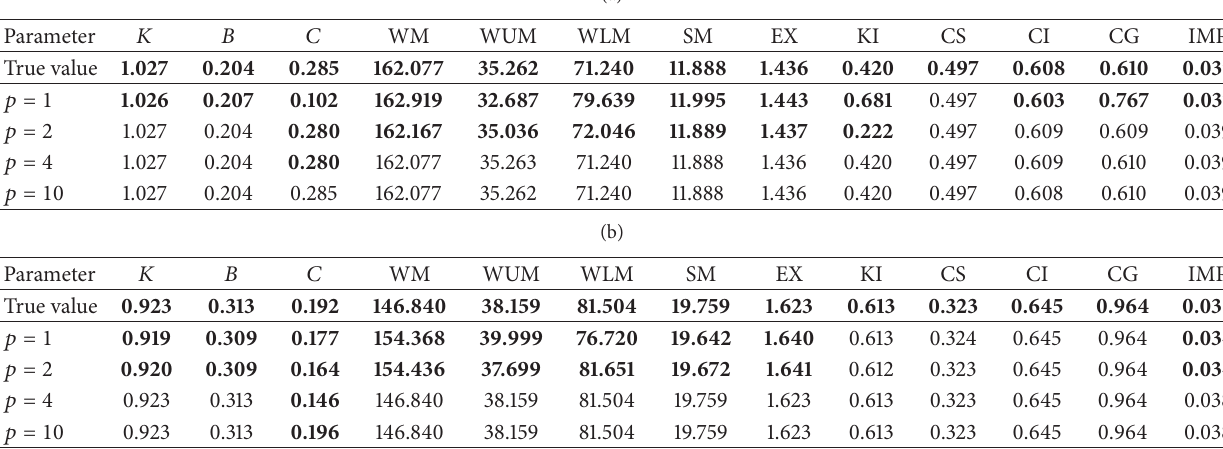
Table 3: (a) Parameter optimization results using ideal data. (b) Parameter optimization results using measured data.